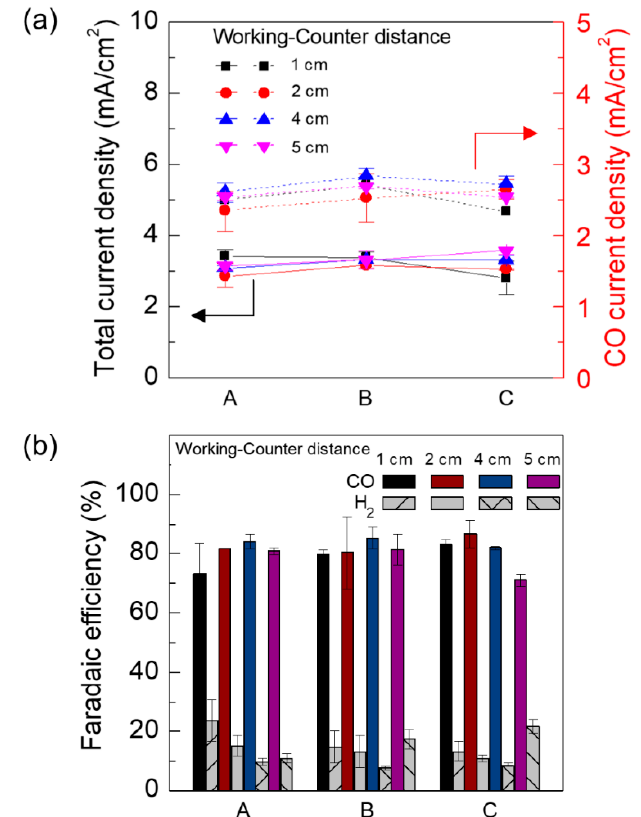
Figure 5. ( a ) Total electrolysis current density and CO production current density of the 25.5 cm 2 Ag GDE according to the position and ( b ) the corresponding FE for CO and H 2 . Ag deposition was performed at 0.83 mA/cm 2 for 50 min with different working-counter electrode distances: 1, 2, 4 and 5 cm. The CO 2 reduction was performed at a constant voltage of − 1.5 V (vs. SCE) in a laboratory-made H-type cell. 0.5 M KHCO 3 was used for both the anolyte and the catholyte.